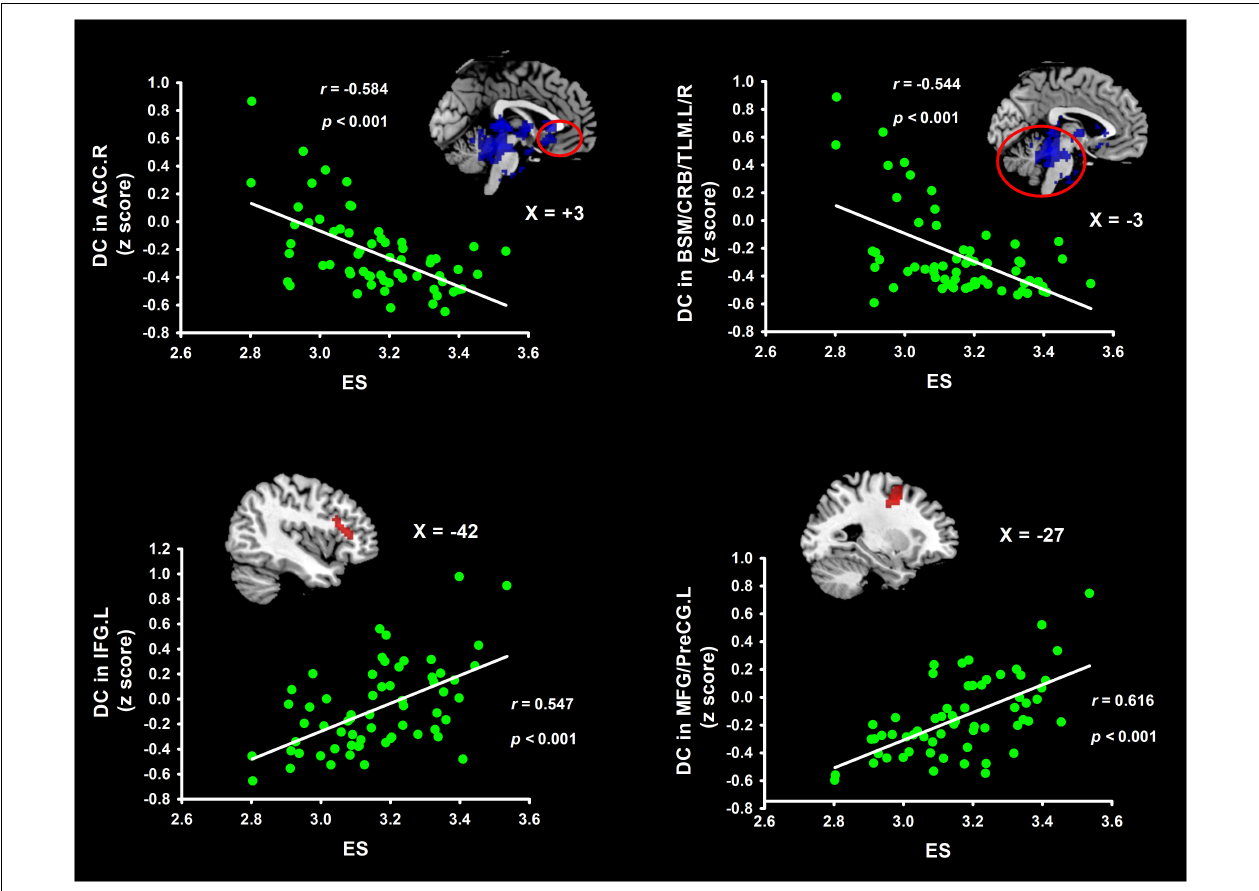
FIGURE 1 | Clusters indicating correlations in weighted DC maps with ES. These brain clusters contain the IFG, MFG/PreCG, ACC, and BSM/CRB/TLM. Coordinates of Montreal Neurological Institute space were used in the present study. ES, efficiency score of insight; IFG, inferior frontal gyrus; TLM, thalamus; MFG, middle frontal gyrus; BSM, brainstern; PreCG, precentral gyrus; ACC, anterior cingulate cortex; CRB, cerebellum; DC degree